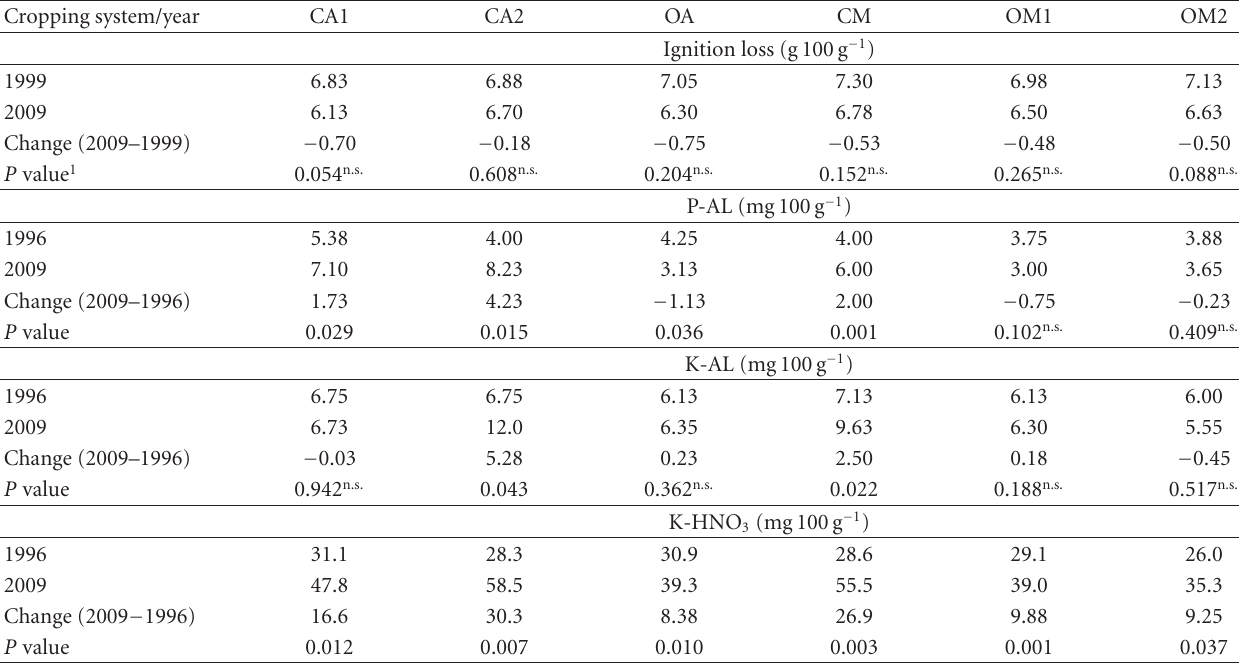
Table 8: Measured changes in selected chemical properties in topsoil (0–25 cm) for the last decade. Cropping system/year CA1